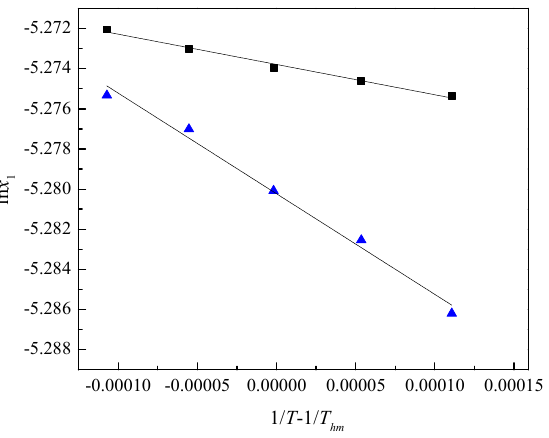
Figure 3. The plot of the natural logarithm of the mole fraction of ( (cid:4) ) caffeine in a saturated 0.1 mol ∙ kg − 1 SS aqueous solution and ( ▲ ) caffeine in a saturated aqueous solution, ln x 1 versus 1 /T − 1 /T hm .